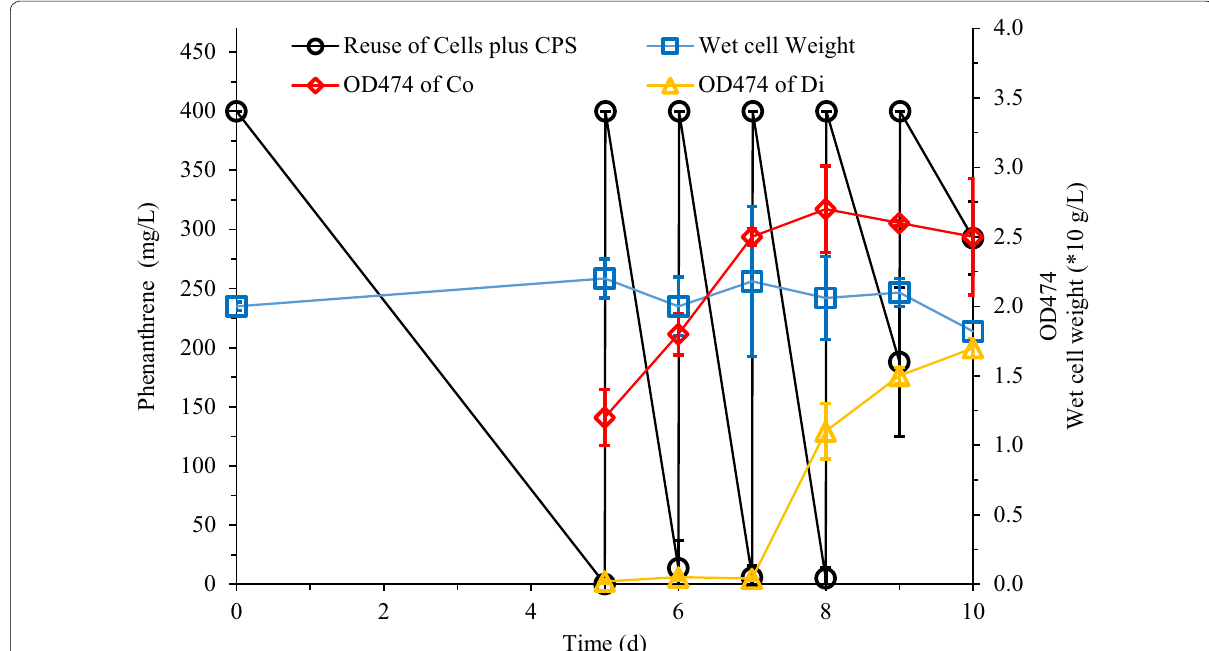
Fig. 3 Reuse of cells plus CPS for phenanthrene biodegradation. S. polyaromaticivorans was inoculated into 30 LB medium in a 150-mL flask and cultured at 30 °C and 160 rpm for 18 h. Cells were collected and then inoculated in CPS to degrade phenanthrene for 5 days. Subsequently, 400 mg/L of phenanthrene was added every other day. Co: coacervate phases; Di: dilute